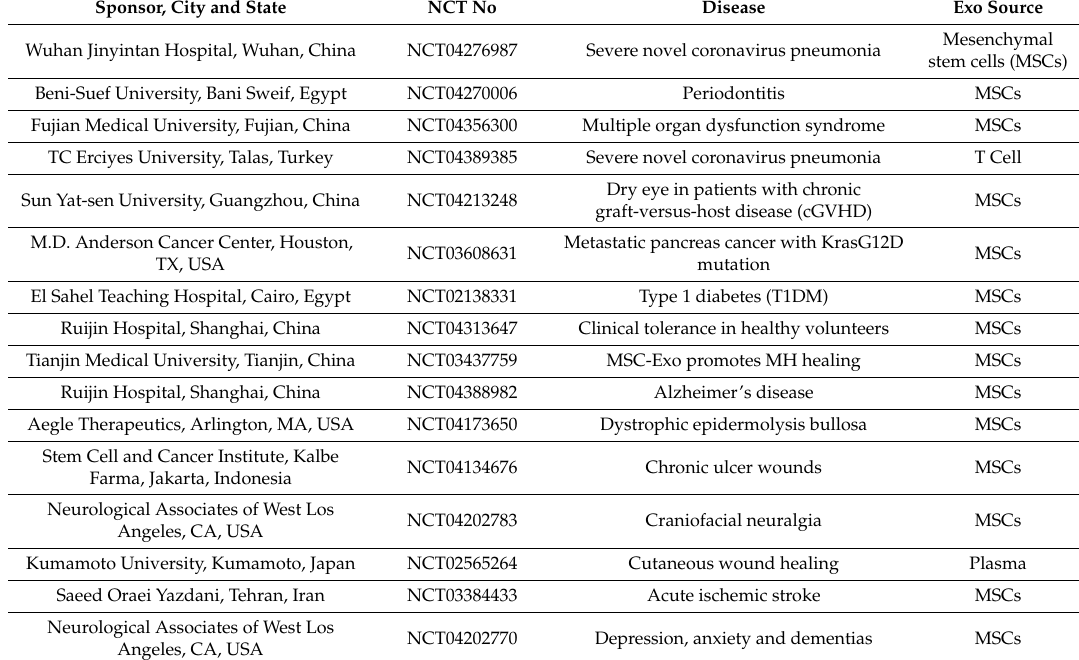
Table 1. A ClinicalTrials.gov search found 12 ongoing national coordinated trials (NCTs) involving exosomes as MSC-based therapeutic agents from di ff erent sources and a further 2 NCTs involving plasma-derived and T cell